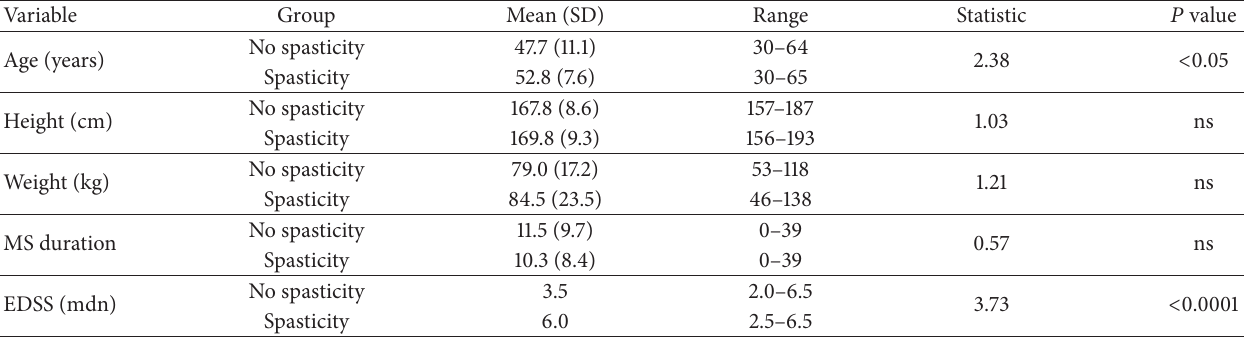
Table 1: Mean, standard deviation, and range of values for demographic and clinical variables for the sample of persons who have multiple sclerosis with ( 𝑛 = 44 ) and without ( 𝑛 = 40 ) leg spasticity.